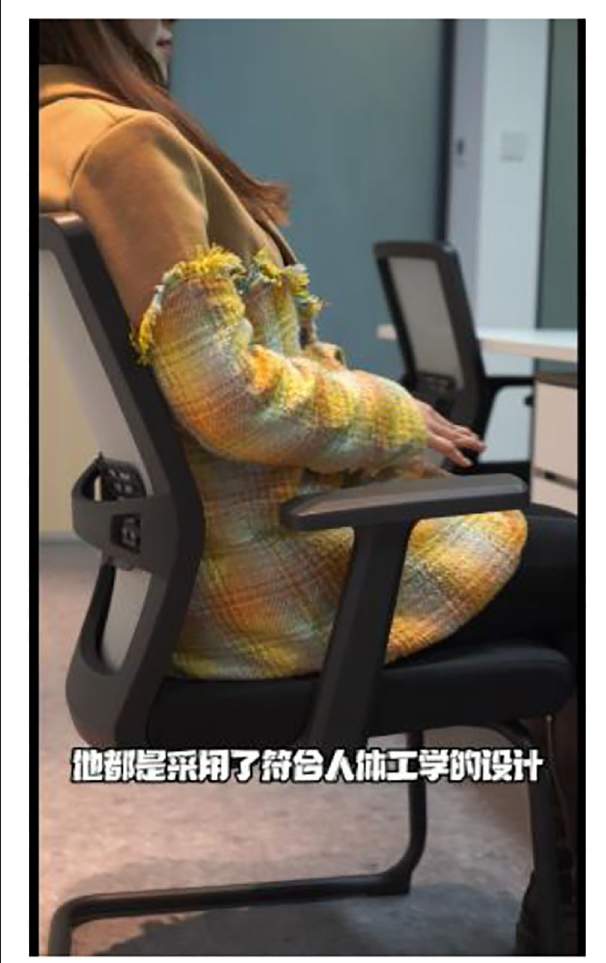
FIGURE 9 | C2 Screenshot of low physical